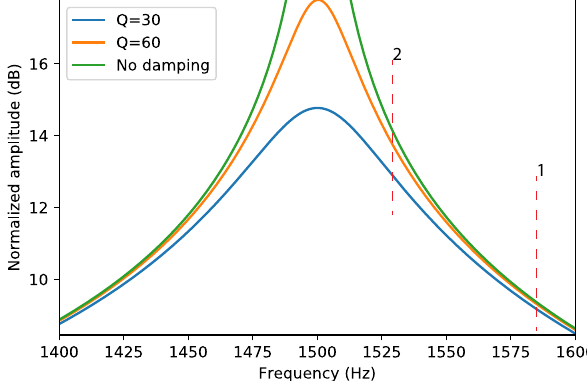
Figure 4. Typical frequency response of a harmonic oscillator which represents the Coriolis mode close to the resonance frequency and at different values of the quality factors. In this example, the resonance frequency is set to 1500Hz. The two red dashed lines indicate possible values of the resonance frequency of the actuation mode. In situation 2, the sensitivity is higher, however at the expense of an increased dependence on the value of the quality